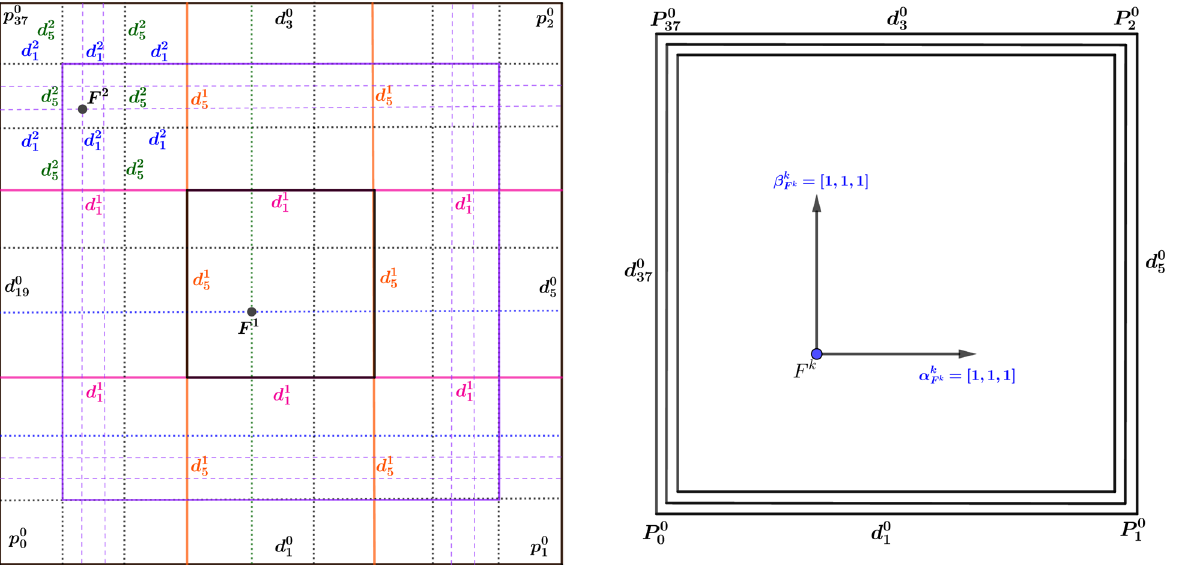
Figure 8. Updating of the mask parameters around the face point after two and three refinement steps. Left: the mask parameters of the face point F 1 and F 2 . Right: according to (4), the mask parameters are replaced by [1, 1, 1] and [1,1, 1] .